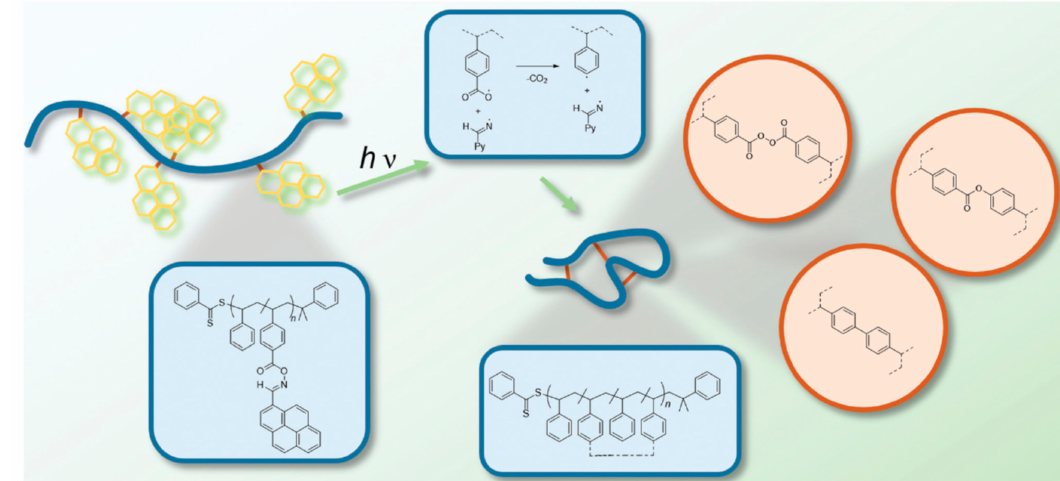
Figure 7. Schematic illustration of the synthesis at a high dilution of self-reporting SCNPs through intrachain coupling of radicals generated from pyrene-substituted oxime ester moieties under LED light irradiation ( λ = 430–435 nm). Chain folding was accompanied by the release of pyrene units inducing fluorescence in the initially non-fluorescent solution. Reprinted from [36] with permission.